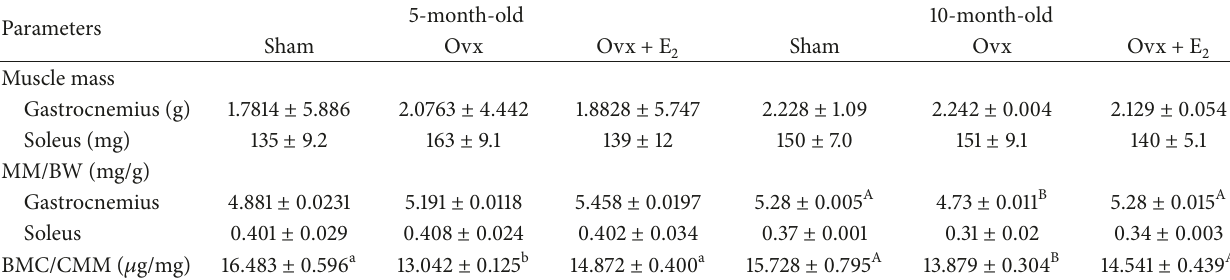
Values are means ± SEM. Values that do not share the same superscript letters in each age category are significantly ( 𝑝 < 0.05 ) different from each other. MM, muscle mass; BW, body weight, BMC, right tibia bone mineral content; CMM, combined muscle mass ( 𝑛 = 6 per treatment